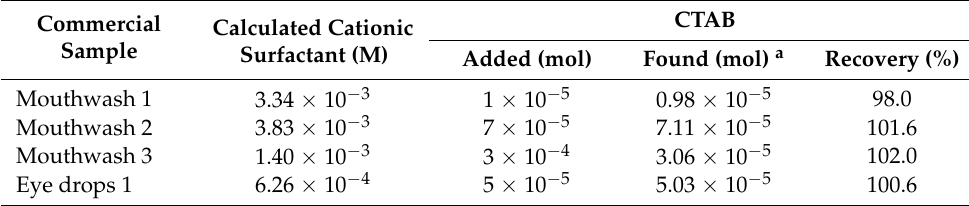
Table 4. The results of the direct potentiometric titrations of the commercial samples with the standard addition method by adding the known quantity of CTAB and by using the DHBI–TPB surfactant sensor as the end-point indicator and DDS (4 × 10 − 4 M) as the